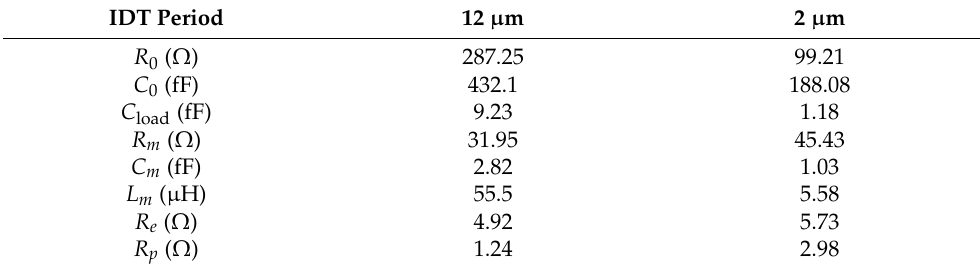
Table 2. Electro-mechanical parameters extracted from the measured frequency responses of AlN